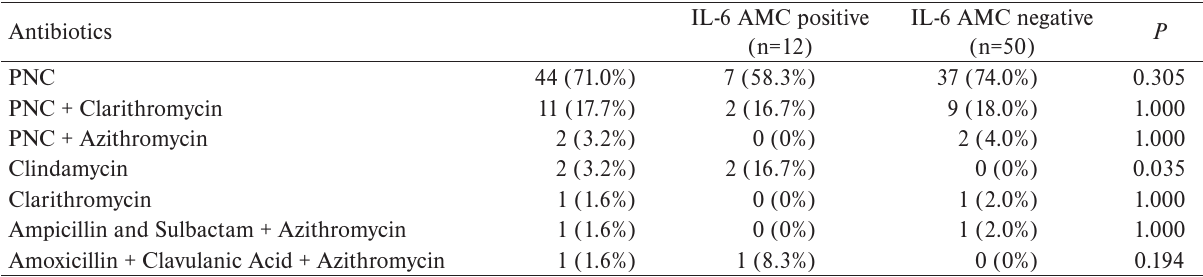
Table 4. Antibiotic treatment in women with PPROM.